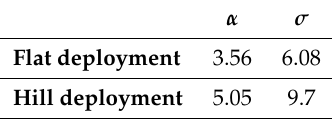
Table 5. Path-loss exponent and shadowing standard deviation for flat and hill